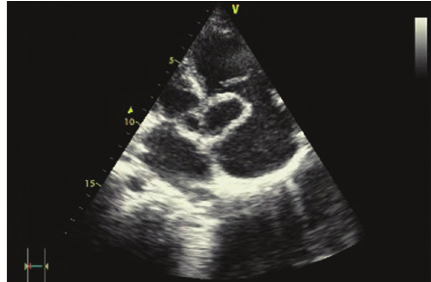
Figure 1: Sinus Valsalva aneurysm in apical five-chamber view.